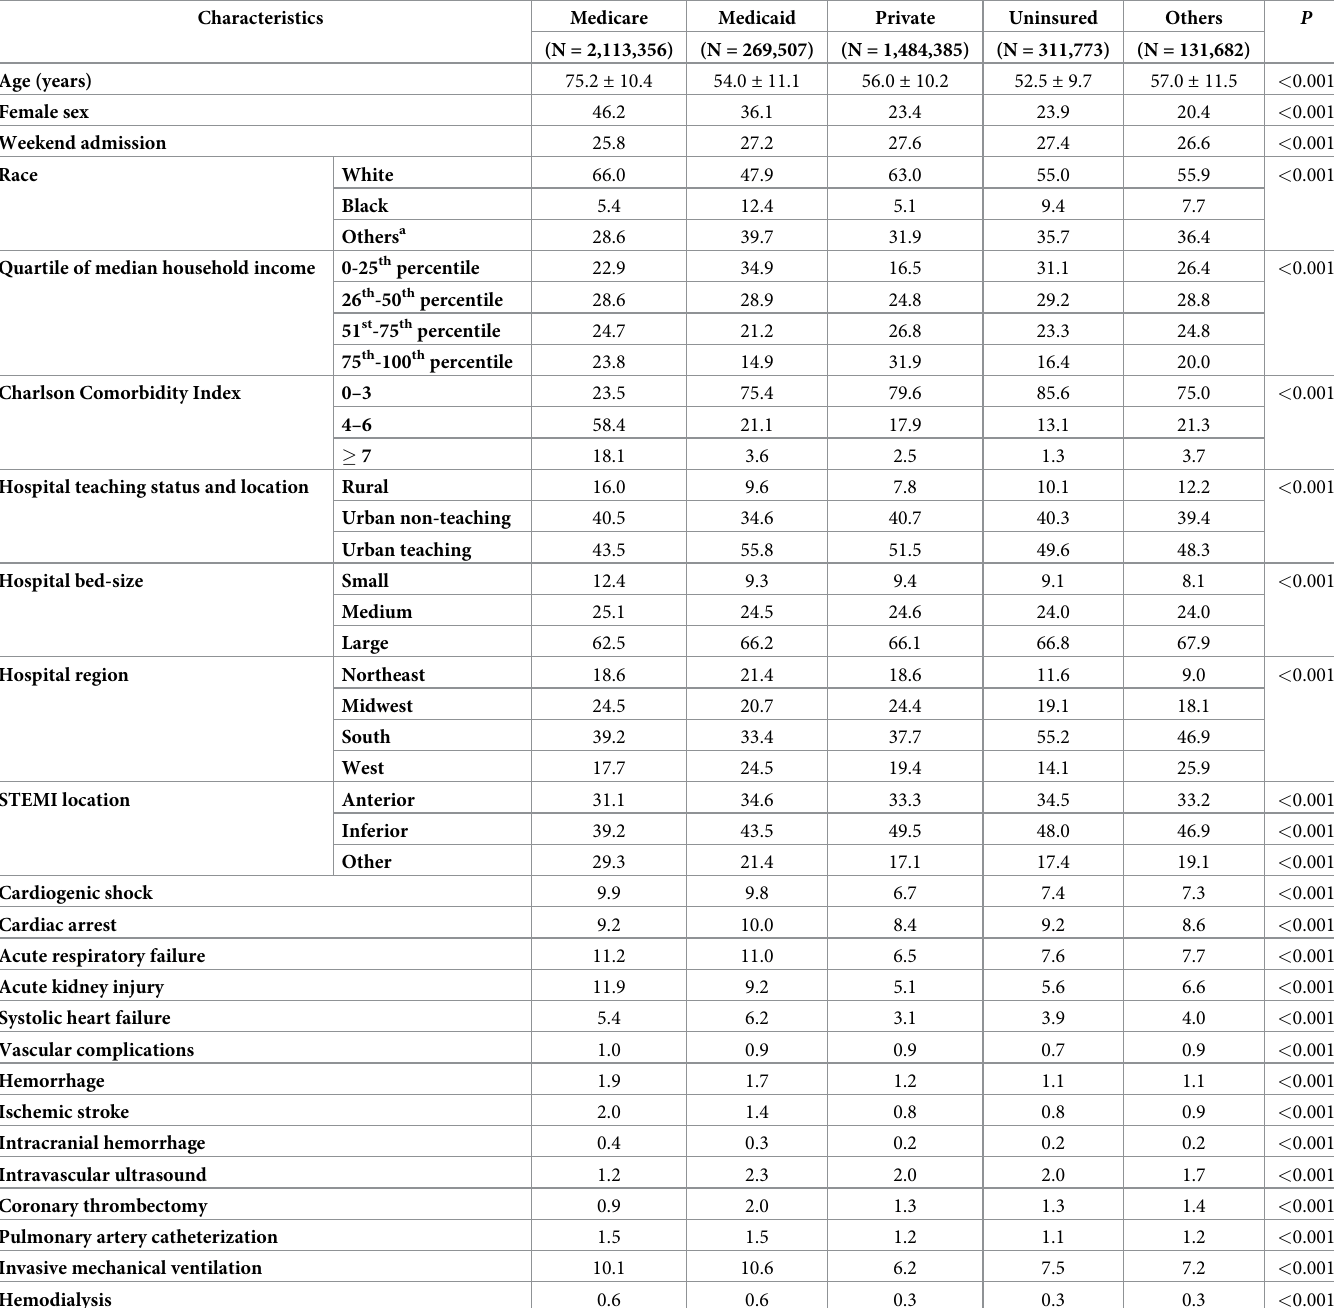
Table 1. Characteristics of STEMI admissions stratified by primary payer status.